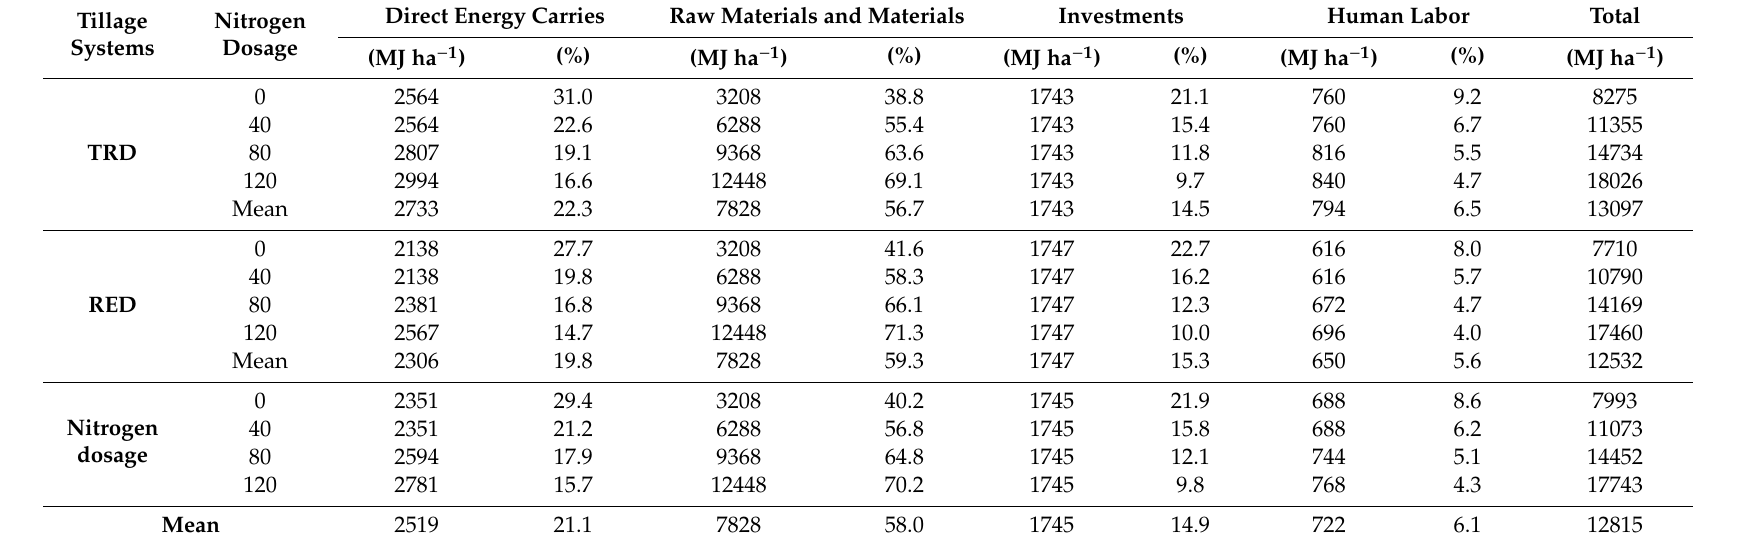
Table 3. Energy inputs and their structure in spring Triticale